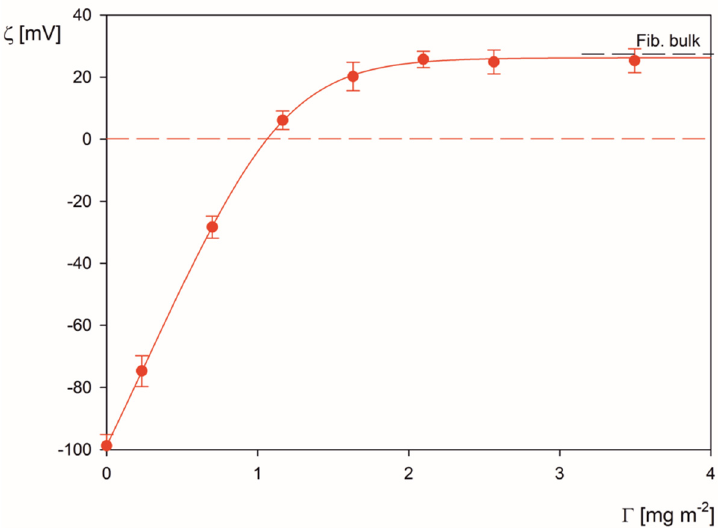
Figure 2. Zeta potential of the LS particles vs. the nominal coverage of the fibrinogen corona Γ ; pH 3.5, 0.01 mol L − 1 NaCl. The points denote experimental results obtained for the particle concentration of 100 mg L − 1 using the LDV method, and the solid line shows the theoretical results calculated from the electrokinetic